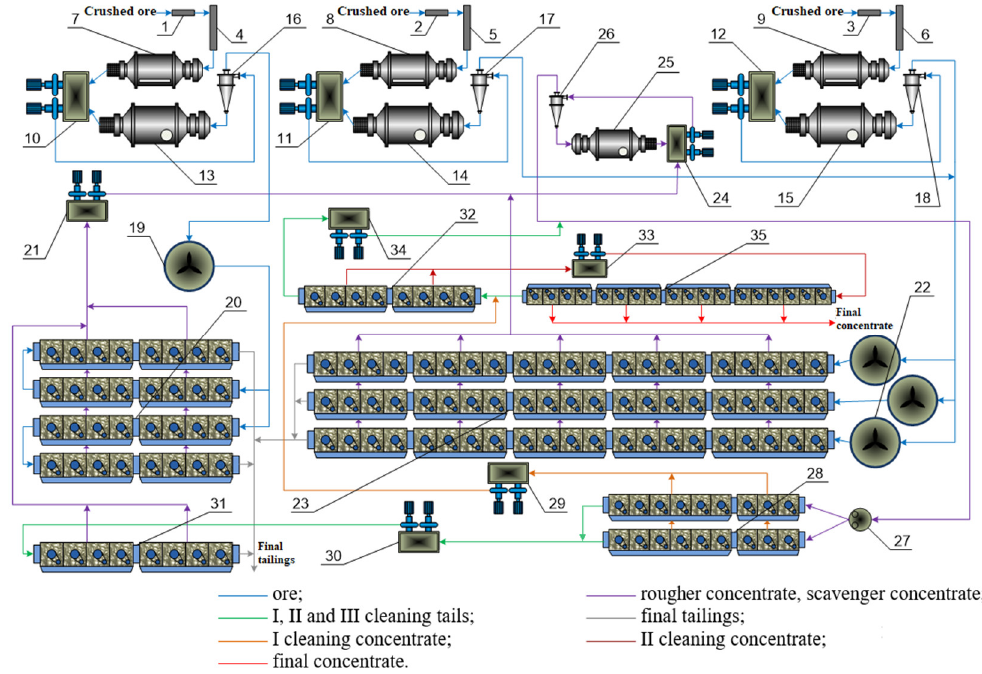
Figure 1. Process flow diagram of Veliki Krivelj flotation plant: 1–6—conveyor belts; 7–9—rod mills; 10–12, 21, 24, 29, 30, 33, 34—centrifugal slurry pumps; 13–15, 25—ball mills; 16–18, 26— hydrocyclones; 19, 22—agitators; 20, 23—roughing flotation cells; 27—divider; 28—first cleaning cells; 31—scavenging cells; 32—second cleaning cells; 35—third cleaning cells (Adapted from